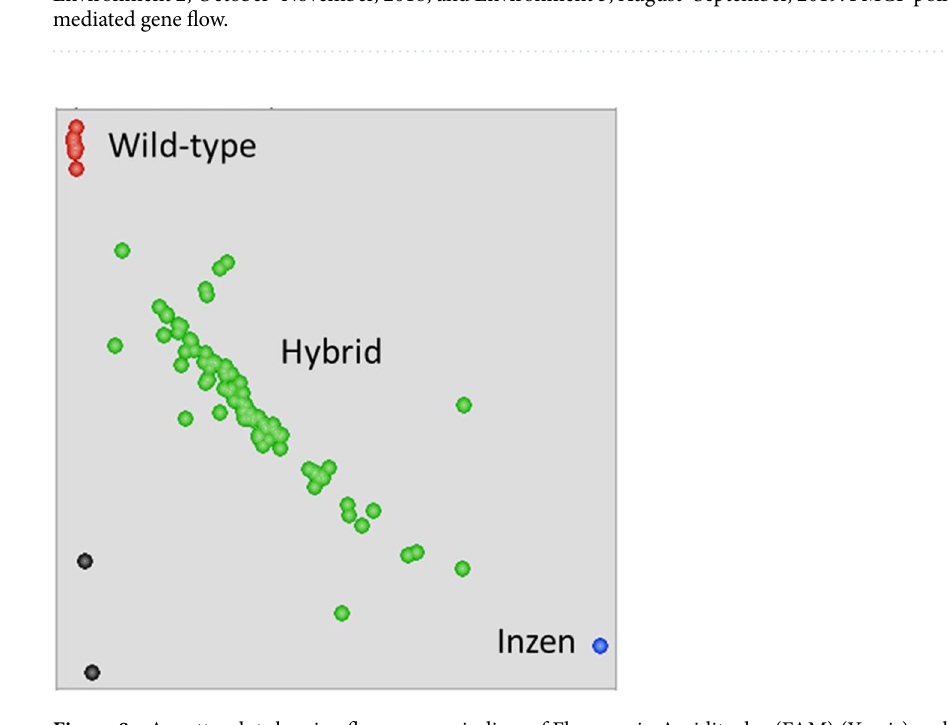
Figure 8. A scatterplot showing fluorescence indices of Fluorescein Amidite dye (FAM) (Y-axis) and Hexachloro-fluorescein dye (HEX) (X-axis) fluorophores for hybrid progenies (90 samples),